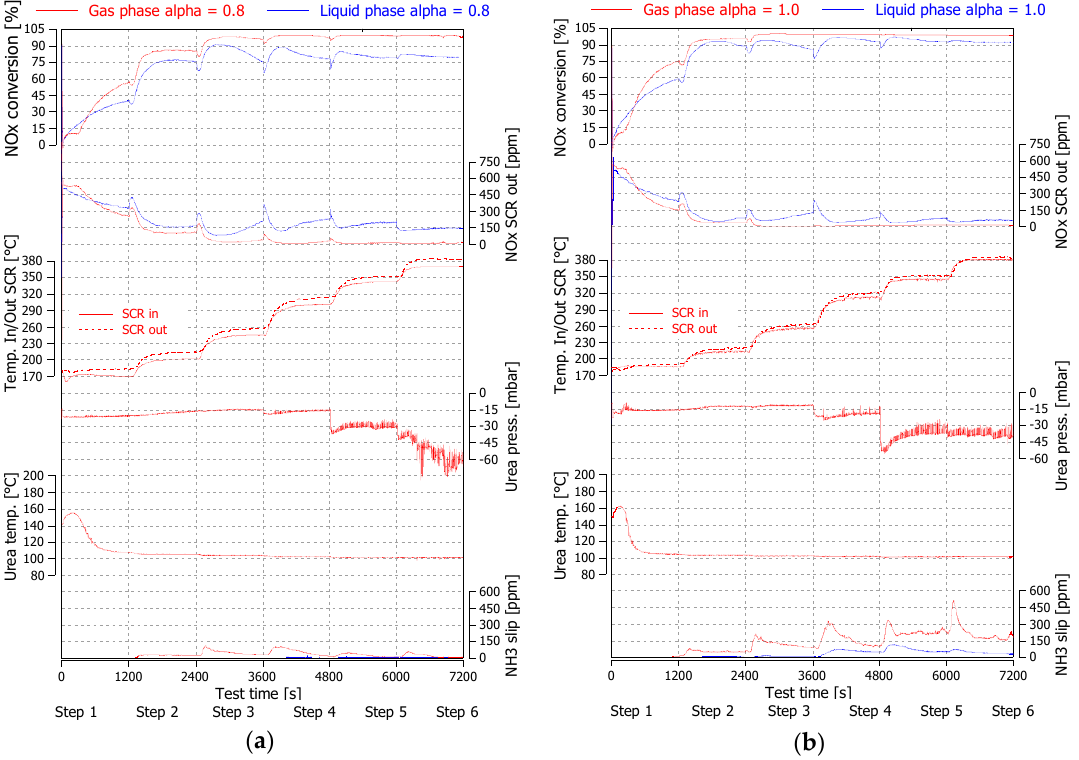
Figure 1. Comparison of results of standard and gaseous urea dosing at α = 0.8 ( a ) and α = 1.0 ( b ). Table 1. Engine operation points during steady ‐ state test cycle.